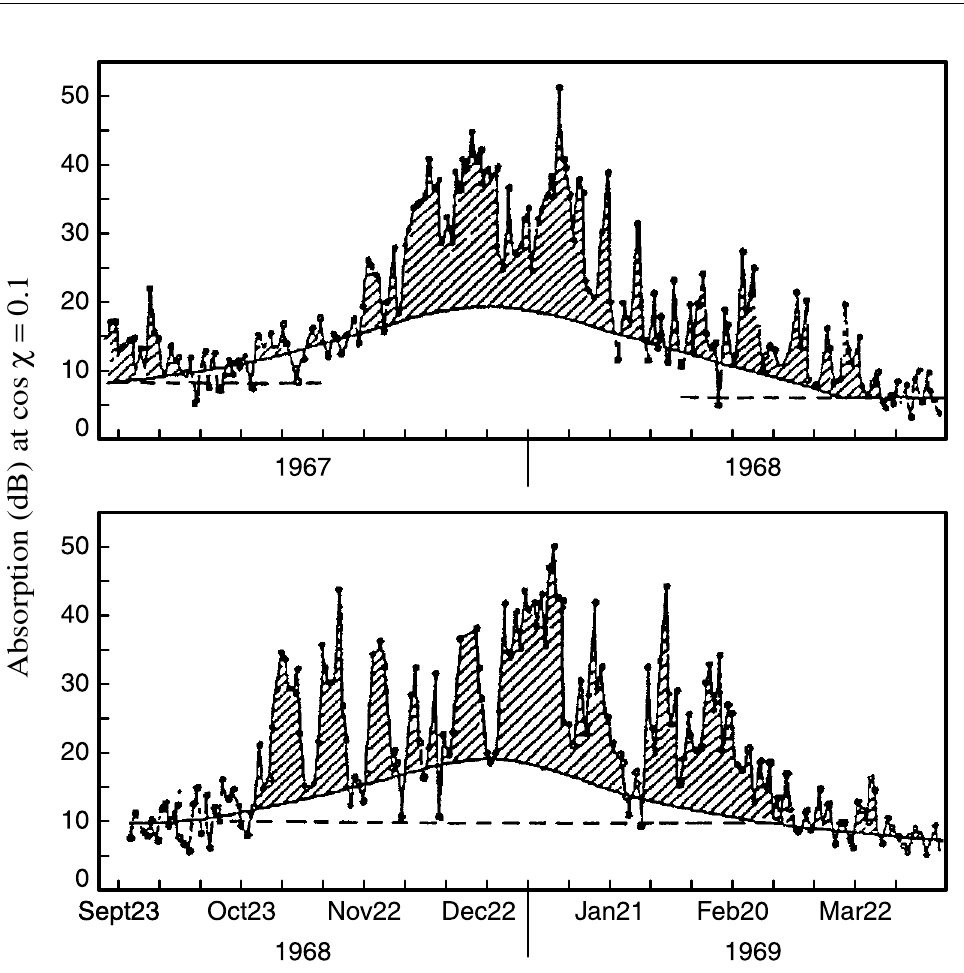
Fig. 2. Winter anomaly of ionospheric radio wave absorption in terms of the absorption at a constant zenith angle during 1967-1969. The dashed line extrapolates the trends from summer (Taubenheim, 1983)